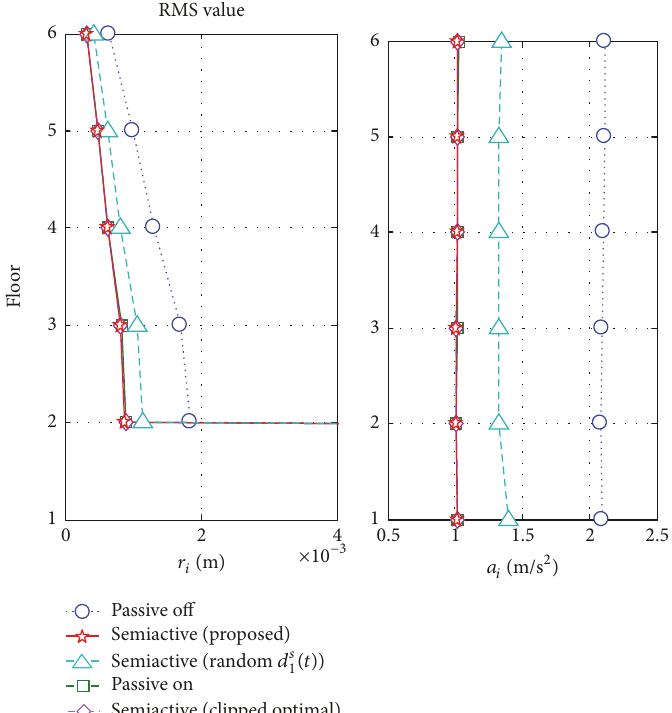
Figure 13: Simulation results for the Hachinohe NS (1968) earthquake disturbance; RMS values of the relative displacement between neighboring floors and absolute acceleration of each